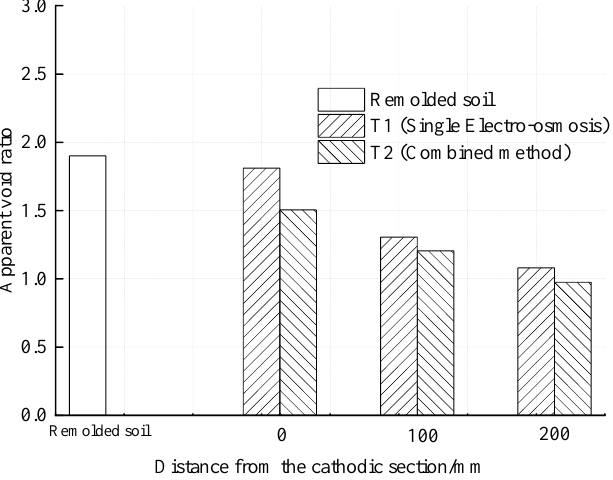
Figure 10. The soil’s apparent void ratio of T1 and T2.